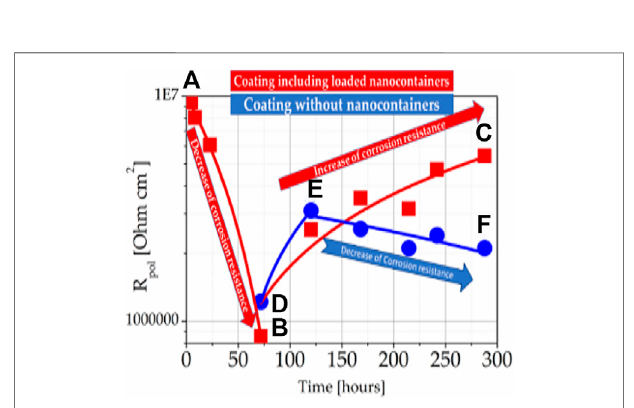
FIGURE6 | R pol versusthe time ofexposure to0.5 MNaCl (aq) in epoxy coatingwith( (A – C) route)andwithout( (D – F) route)CeMo(8-HQ)onMgZK10